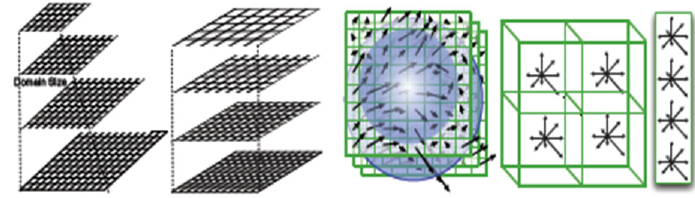
Figure 3. The DSP-SIFT feature extraction process.